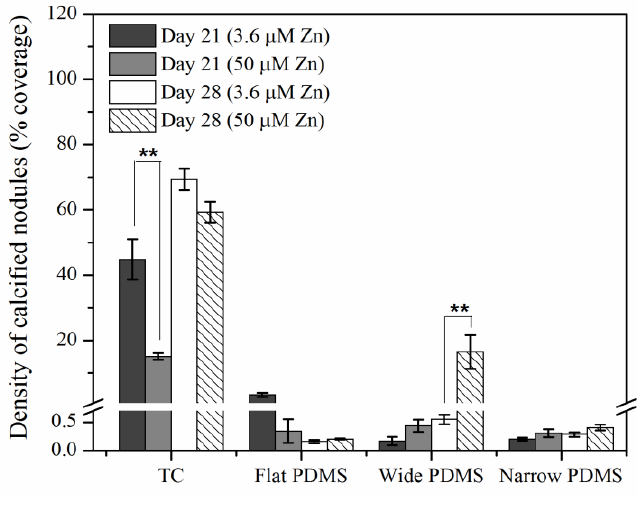
Figure 6. Quantitative calcified nodule density in MC3T3-E1 cell cultures after 21 and 28 days of exposure to induction medium. Densities represent the average area coverage of up to six fields of view collected from three independent experiments. Double asterisks ( ** ) indicate a p < 0.05 level of